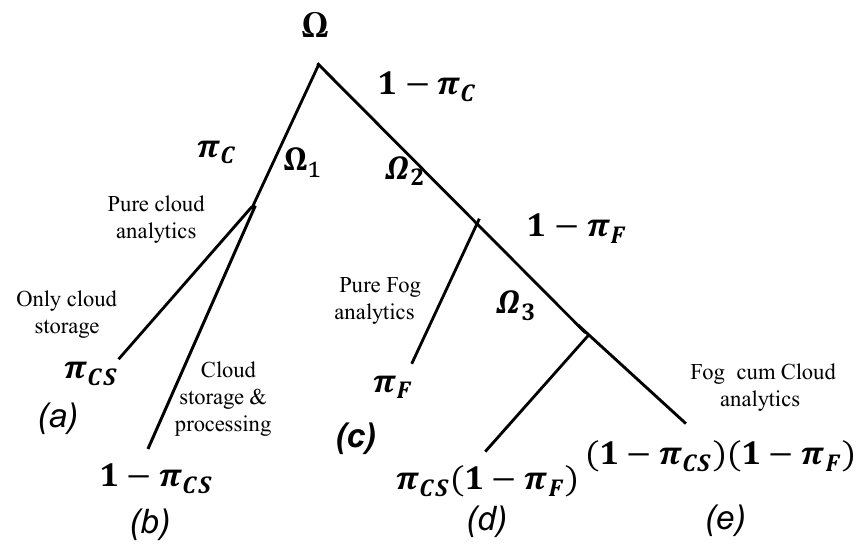
Figure 2. Probabilistic decision tree depicting the workload offloading strategy .